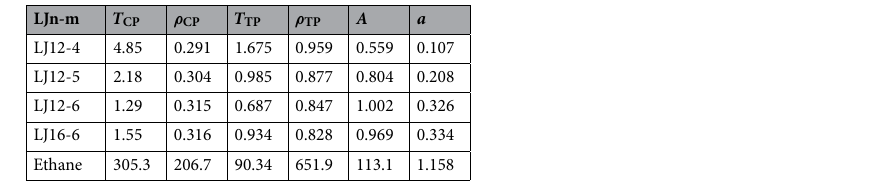
Table 1. The values of densities and temperatures of critical and triple points and parameters of fits by Eq. (7) for considered